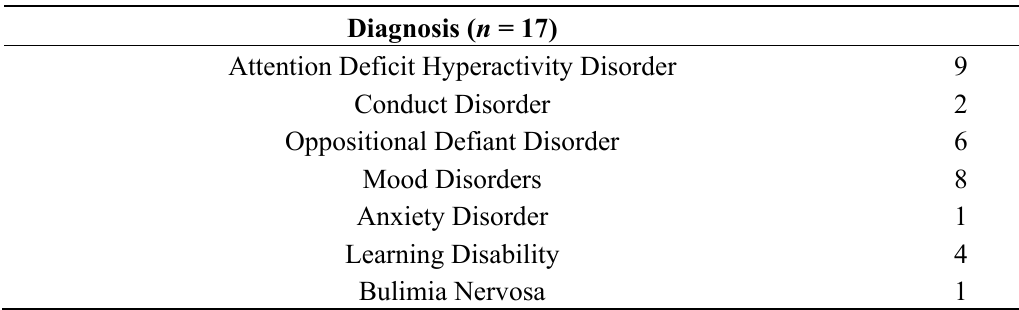
Table 2. Frequency of comorbid diagnosis of youth in